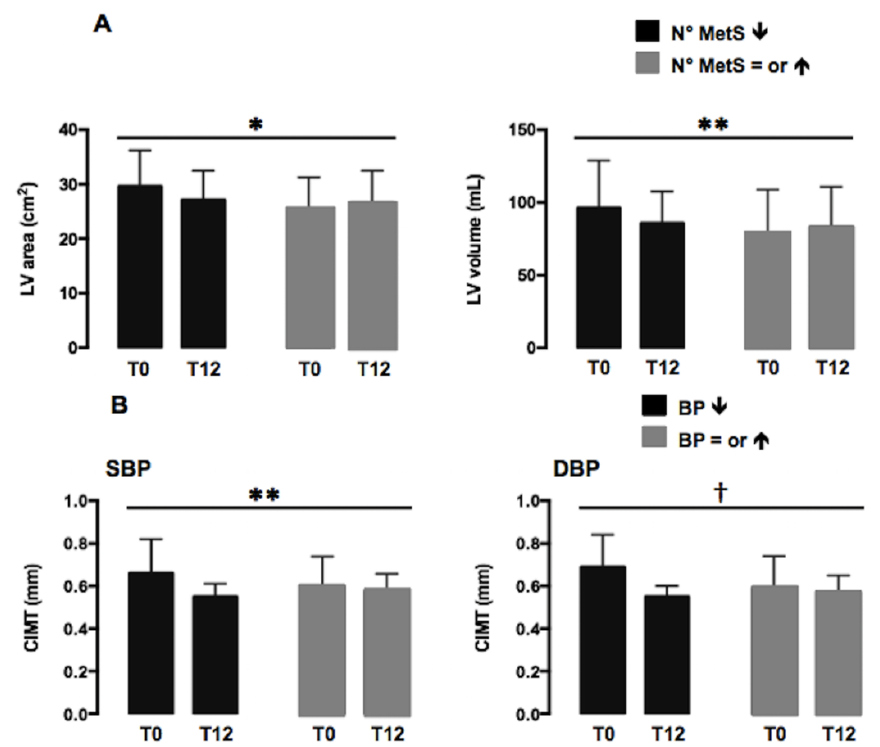
Figure 2. ( A ) Variations of LV area and volume after a 12-month healthy lifestyle intervention in subjects with (black bars) or without (grey bars) a reduction of the number of metabolic syndrome (MetS) criteria according to NCEP-ATPIII classification [17]. ( B ) Variations of CIMT after a 12-month healthy lifestyle intervention in subjects with (black bars) or without (grey bars) a reduction of systolic (SBP) and diastolic (DBP) blood pressure. Data are expressed as marginal mean ± SEM. Data are significant in interaction (* p < 0.01; ** p < 0.05; † p < 0.007). T0: baseline; T12: after 12 months of behavioral intervention.